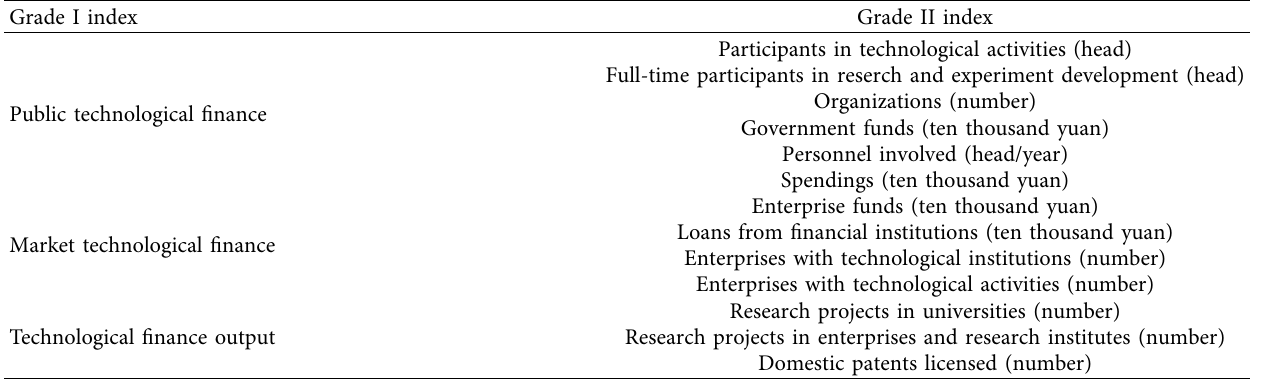
Table 1: Construction of technological finance